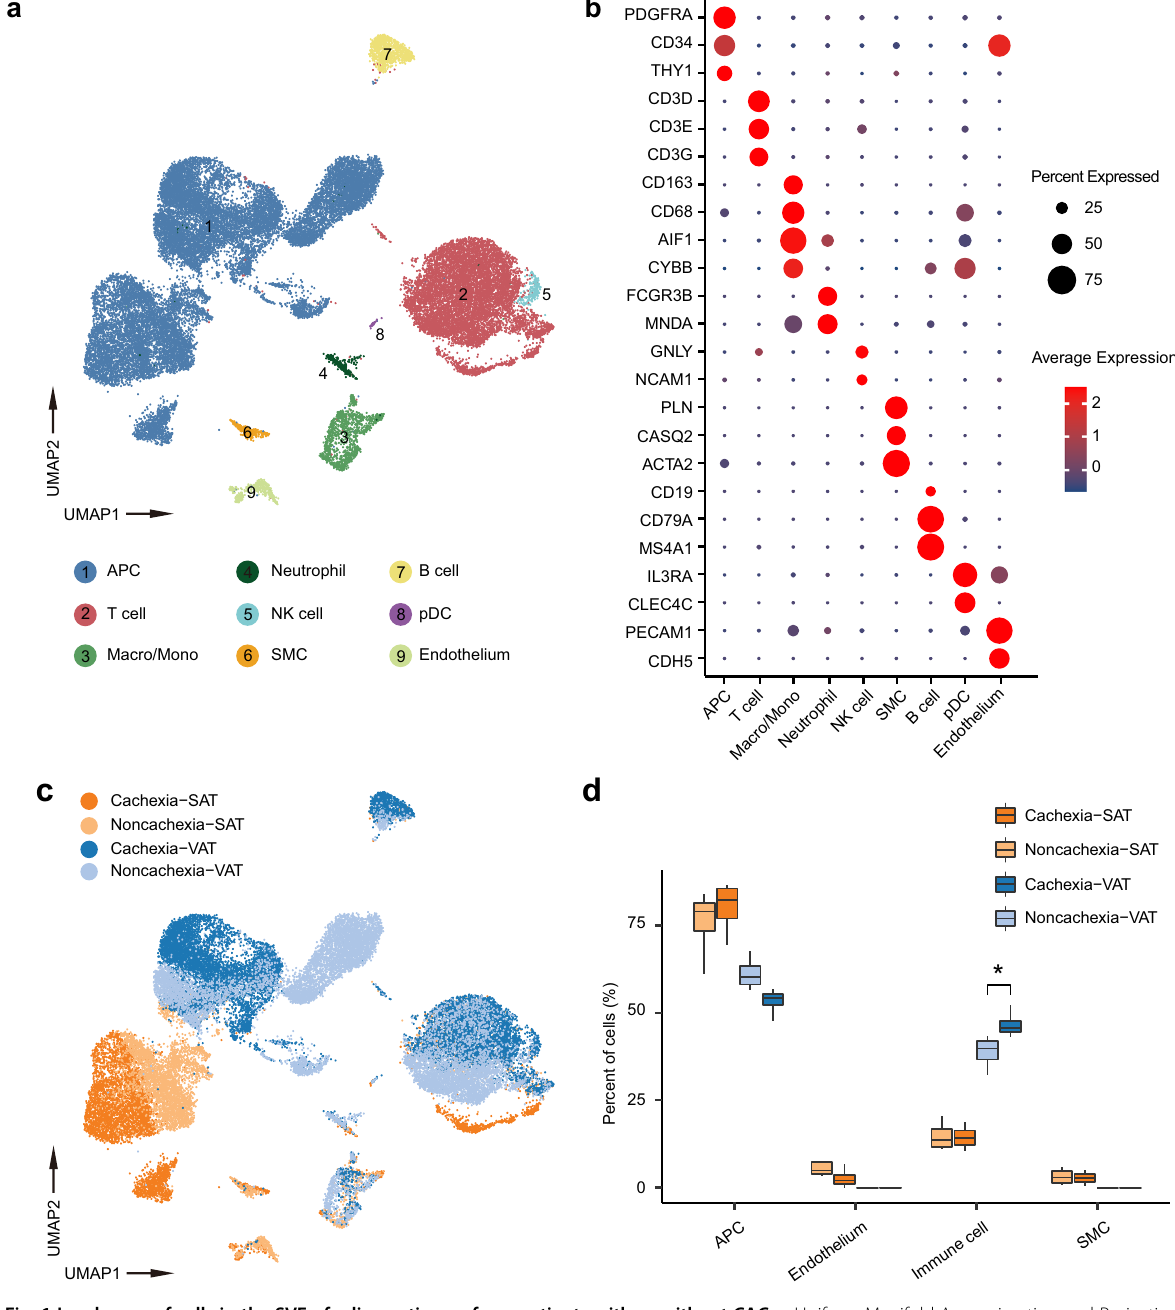
Fig. 1 Landscape of cells in the SVF of adipose tissues from patients with or without CAC. a Uniform Manifold Approximation and Projection (UMAP) plot of 10X genomics-based single cells showing 9 major cell types by manual annotation. b Bubble heatmap showing expression levels of selected marker genes for each cell type. c UMAP plot showing the origins of cells. d Boxplot showing the proportion of major cell types from patients with ( n = 4) or without ( n = 4) CAC. P -value was determined by unpaired Student ’ s t -test. * P < 0.05. APC, adipose progenitor cell; Macro/ Mono, macrophage/monocyte; NK cell, natural killer cell; SMC, smooth muscle cell; pDC, plasmacytoid dendritic